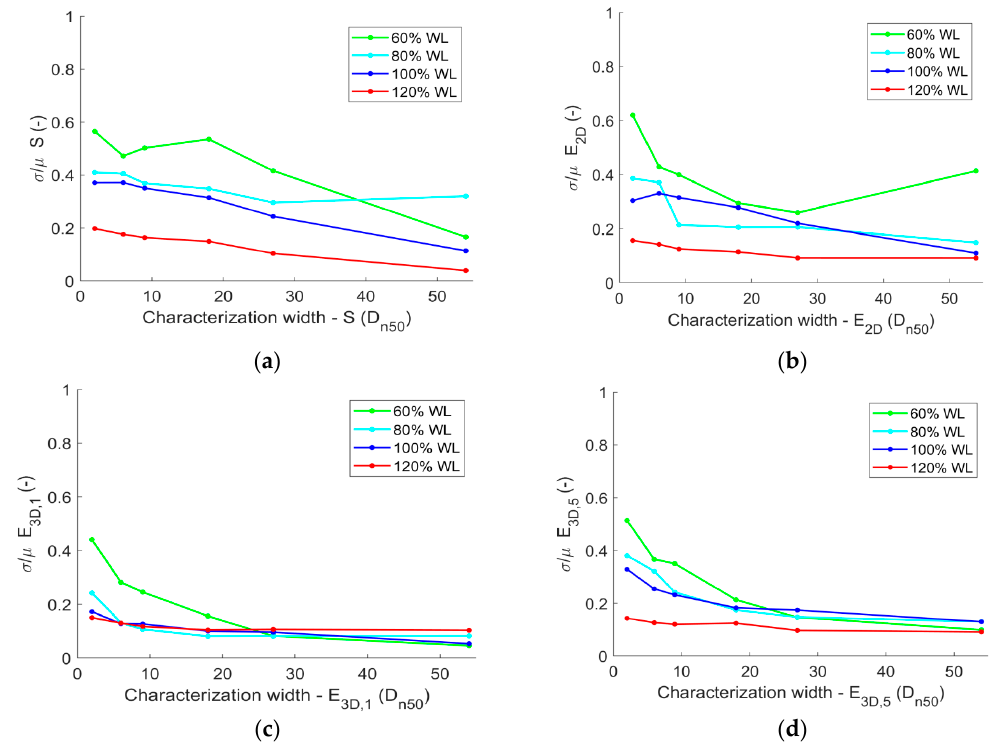
Figure 9. Variation (i.e., standard deviation divided by mean) in the damage versus characterisation width, i.e., width over which the damage is determined (for Series S1). ( a ) S ; ( b ) E 2D ; ( c ) E 3D,1 ; ( d ) E 3D,5 .